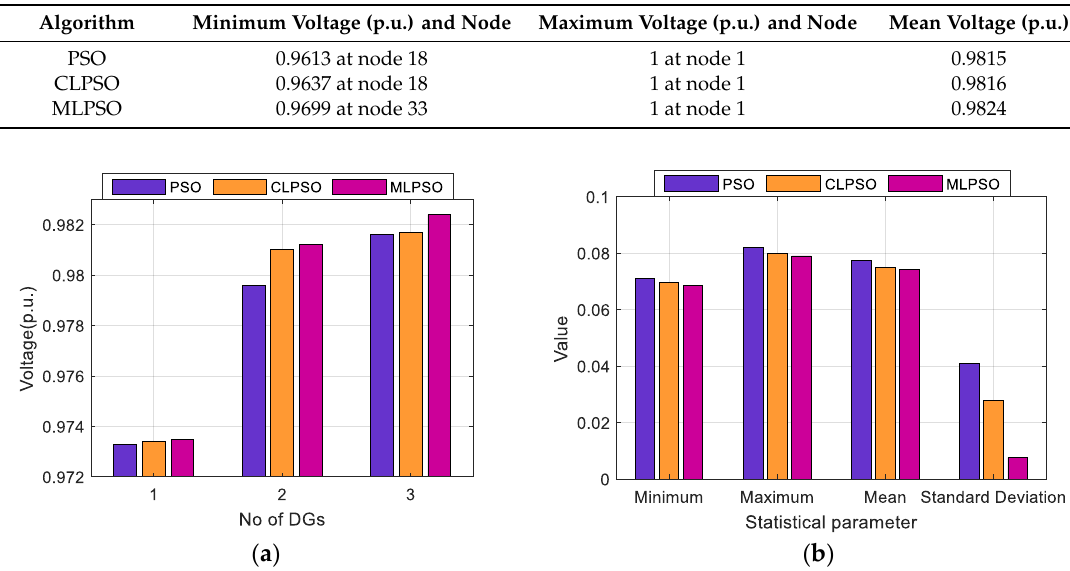
Figure 8. Variation of ( a ) mean voltage improvement with the number of DGs and, ( b ) statistical parameters of PSO variants for the standard IEEE 33 bus system.